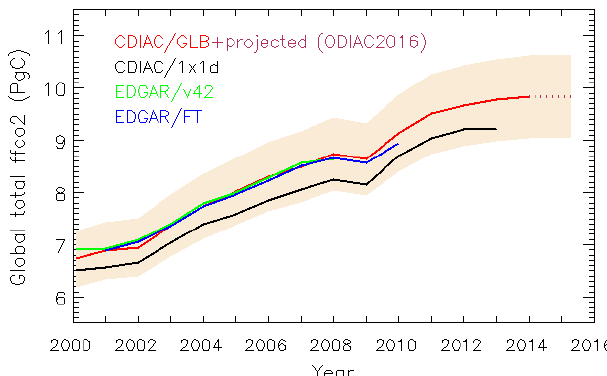
Figure 2. Global emissions time series from four gridded emissions data: CDIAC (red, 2000–2013) plus projected emissions (dashed maroon, 2014–2015) (values taken from ODIAC2016), CDIAC 1 × 1 ◦ (black, 2000–2013), EDGAR v4.2 (green, 2000–2008), and EDGAR v4.2 FastTrack (blue, 2000–2010). The values here are given in the unit of petagrams (equal to a gigaton) of carbon per year. The shaded area indicated in tan is the 2 σ uncertainty range (8%) estimated for CDIAC global total emissions estimates by An- dres et al.